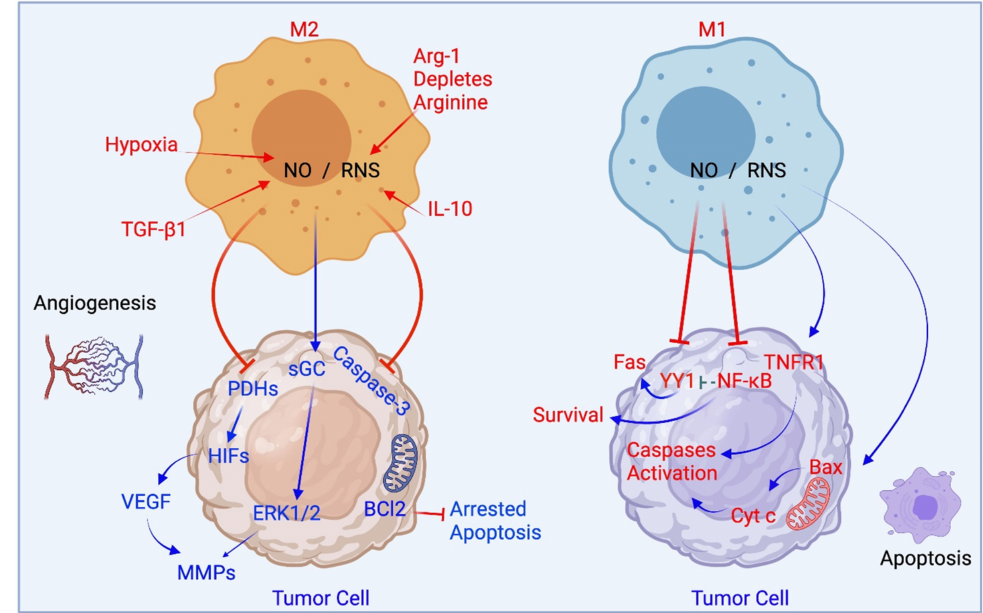
Figure 3. The role of M1-like and M2-like macrophages in apoptosis and